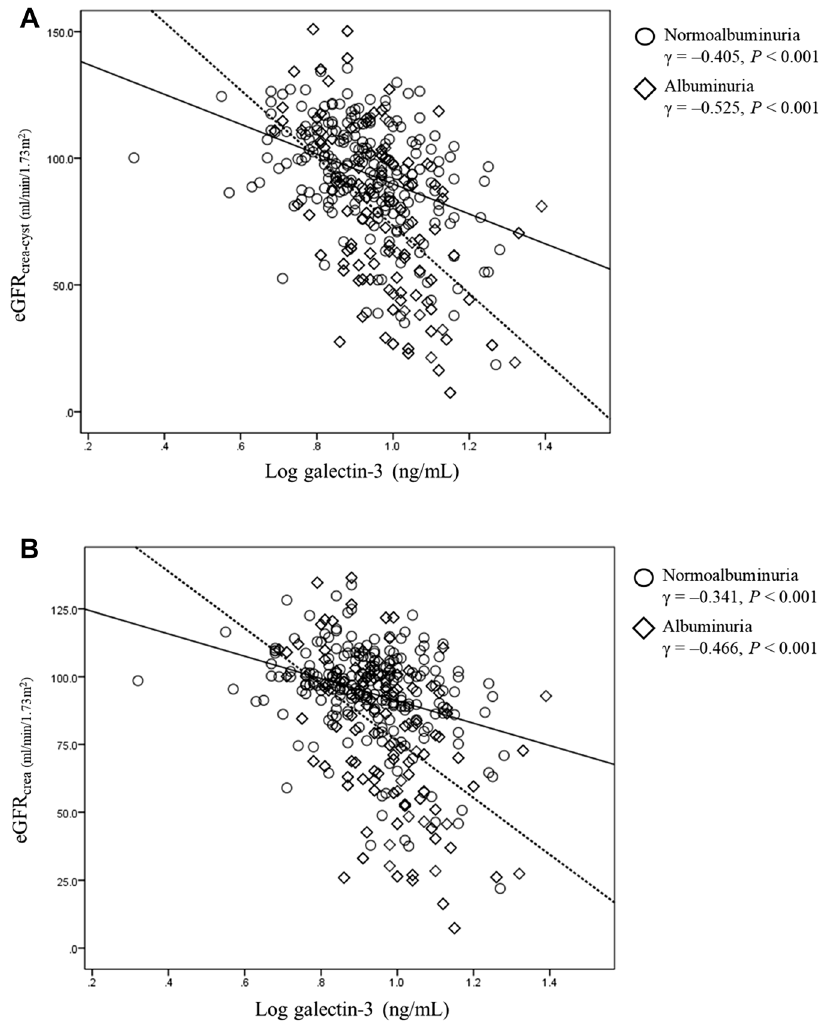
Figure 1. Correlation between galectin-3 concentrations and estimated glomerular filtration rate in patients with T2DM with normoalbuminuria and albuminuria. A Correlation between galectin-3 concentrations and eGFR crea-cyst . B Correlation between galectin-3 concentrations and eGFR crea . eGFR estimated glomerular filtration rate, T2DM type 2 diabetes